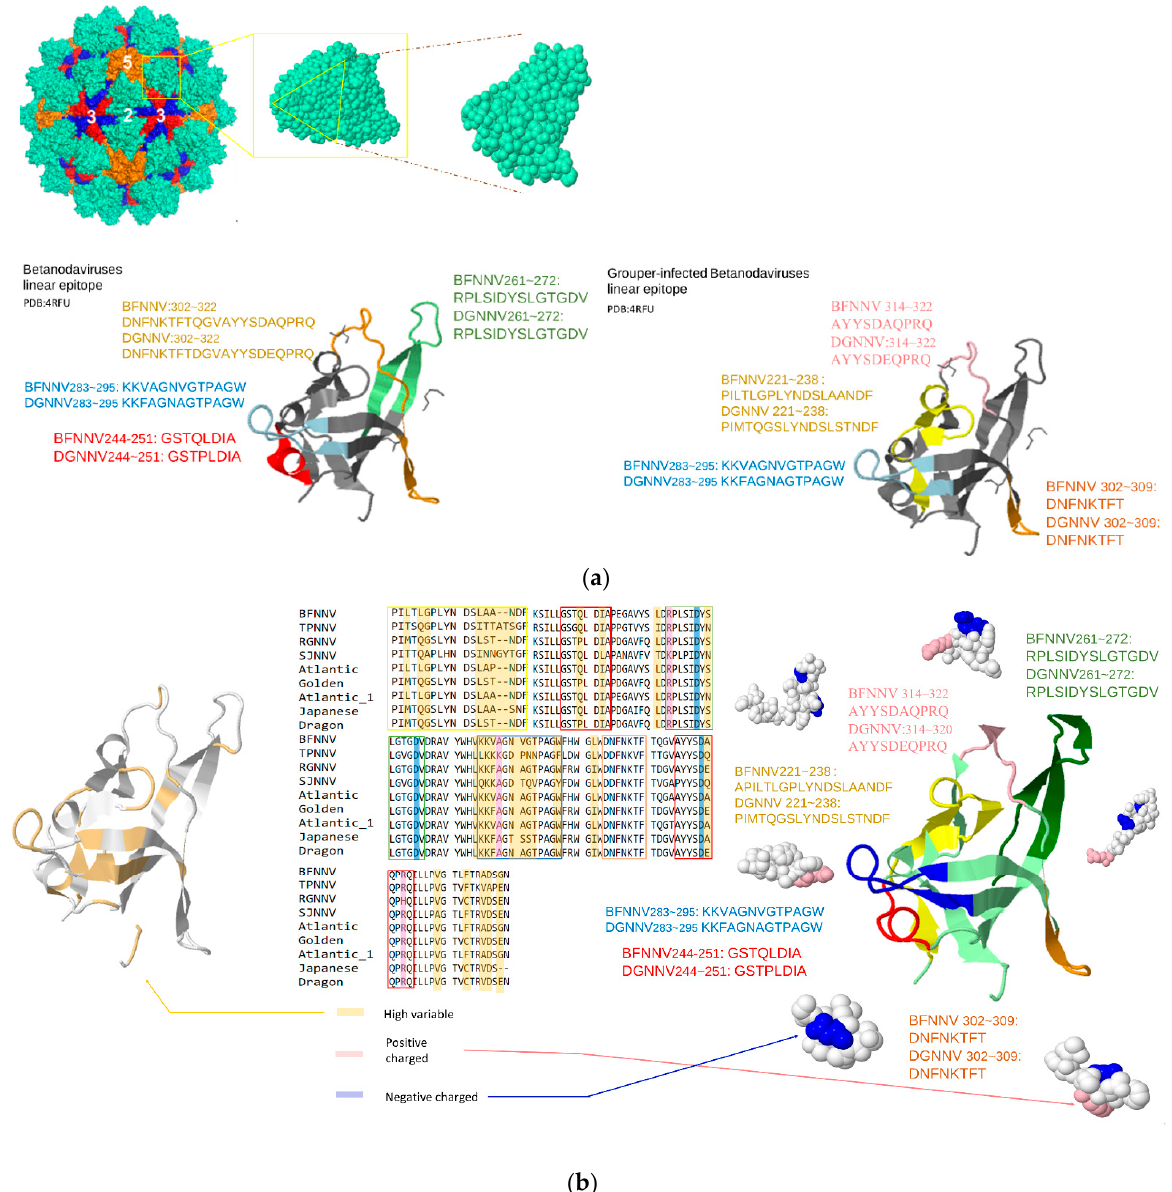
Figure 1. Predicted LEs for betanodavirus and grouper-infecting betanodavirus. P-domain sequence alignment with variable and charged annotation. ( a ) Visualize the predicted epitopes with cartoon style. Predicted epitopes were shown in different colors; ( b ) sequence alignment result and the corresponding hypervariable and charged residues.